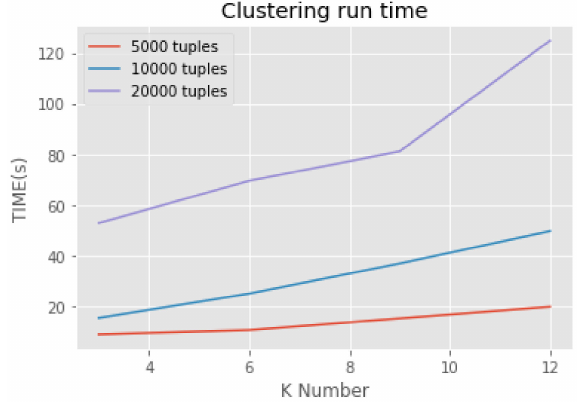
Figure 1. Clustering run